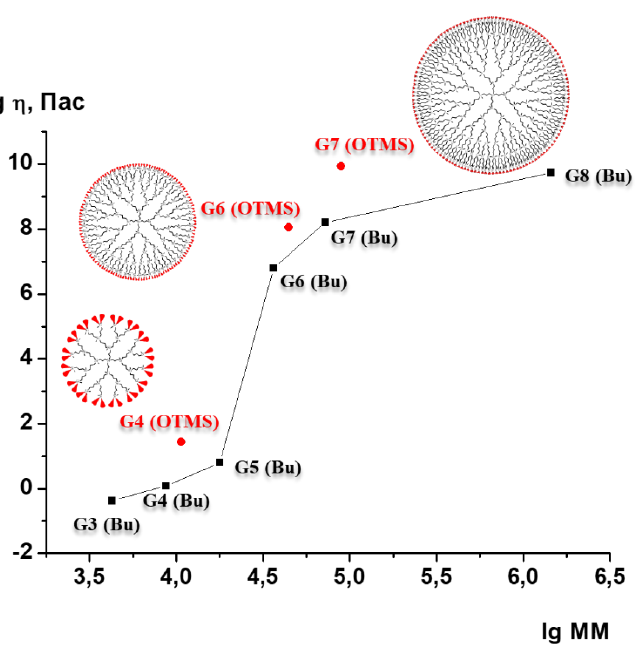
Figure 4. Viscosity of the hybrid polycarbosilane-siloxane dendrimers versus their molecular mass (red circles) compared to the MM dependence of the viscosity of the homologous series of poly(bytil)carbosilane dendrimers (black squares) studied earlier